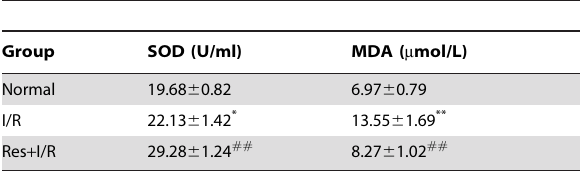
Table 3. The effect of Res on SOD activity and MDA content in